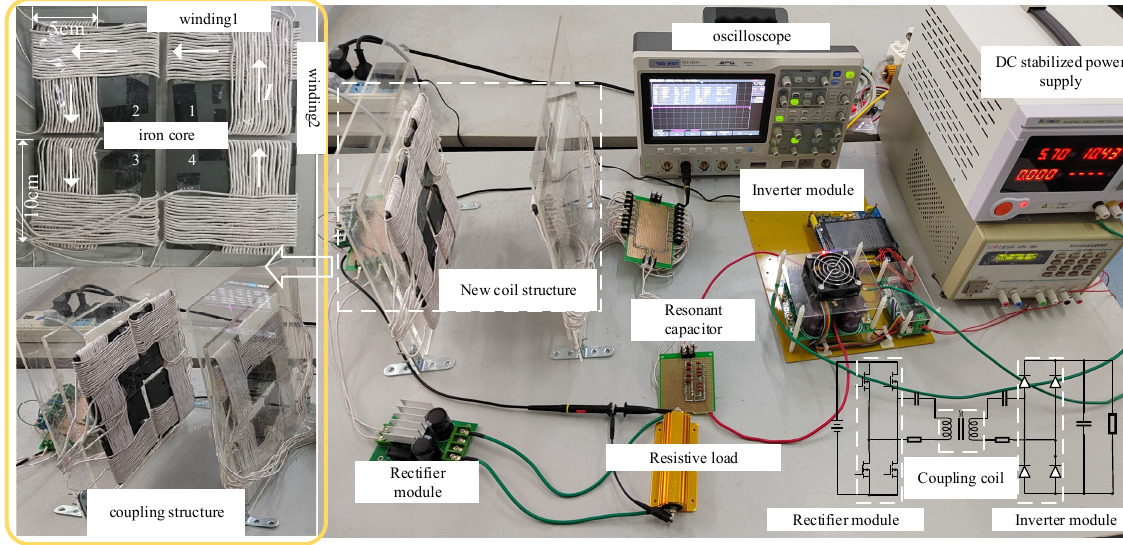
Figure 13. Experimental platform.